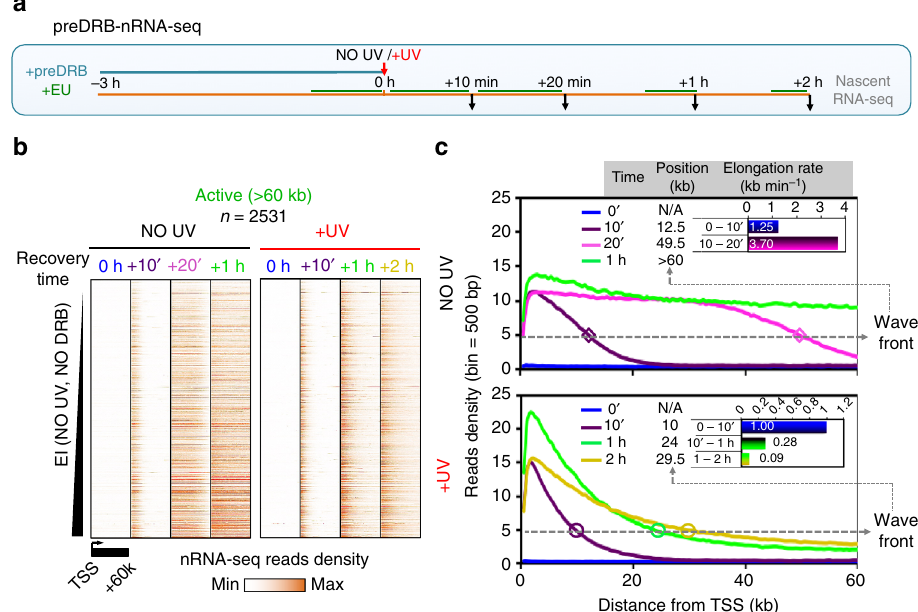
Fig. 3 Stress-triggered de novo transcription in fl ux decelerates progressively. a Scheme of DRB-release methodology (preDRB-nRNA-seq), UV irradiation was performed at 20Jm − 2 see also Methods. b Heatmaps illustrating nascent RNA read densities from TSS to TSS +60 kb, for samples de fi ned in a , as aligned at individual (rows) active genes larger than 60kb and ranked by increasing steady-state EI (Fig. 1d). c Average plots of read densities for nascent RNA derived from b , highlighting de novo wave-release of RNAPII. Differences in wave front positions at an arbitrary threshold (dashed line representing the transition from enriched levels to steady-state levels) were used to calculate average ( n = 2531) elongation rates in the indicated time intervals